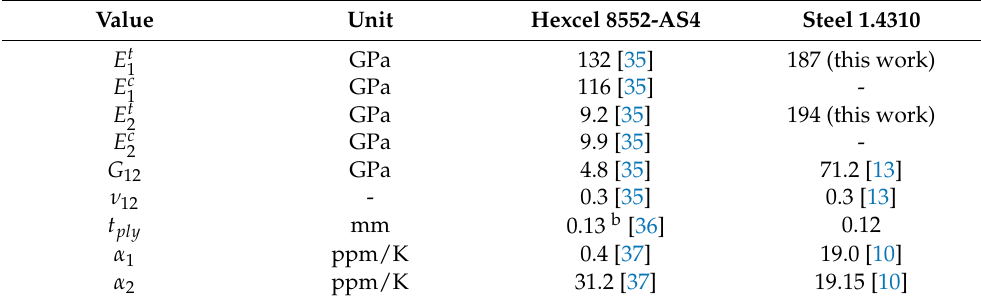
Table 4. Material properties for the single constituents of the CFRP-steel laminates used in this work. The fiber direction (CFRP) and direction of rolling (steel) is indicated by index 1, while index 2 denotes the transverse direction. The superscripts t and c distinguish the properties in tension and